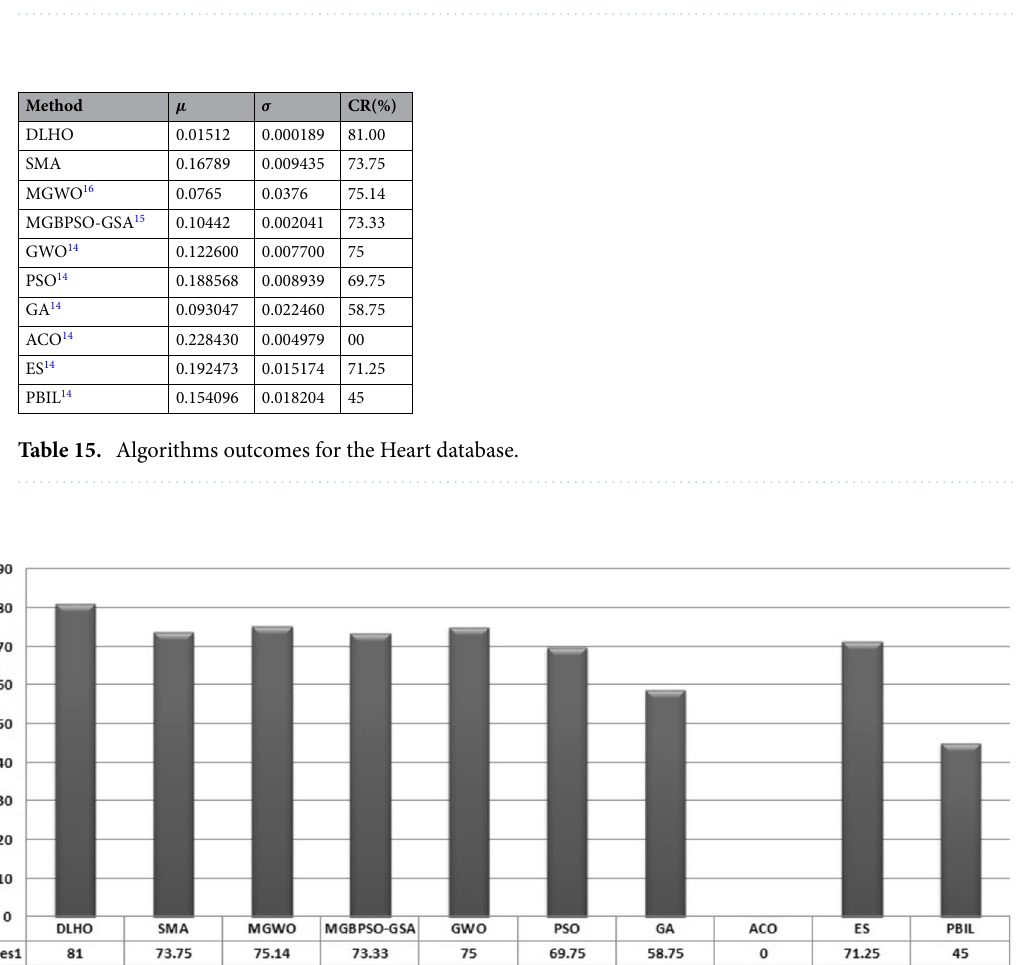
Table 14. Algorithms outcomes for the balloon database.